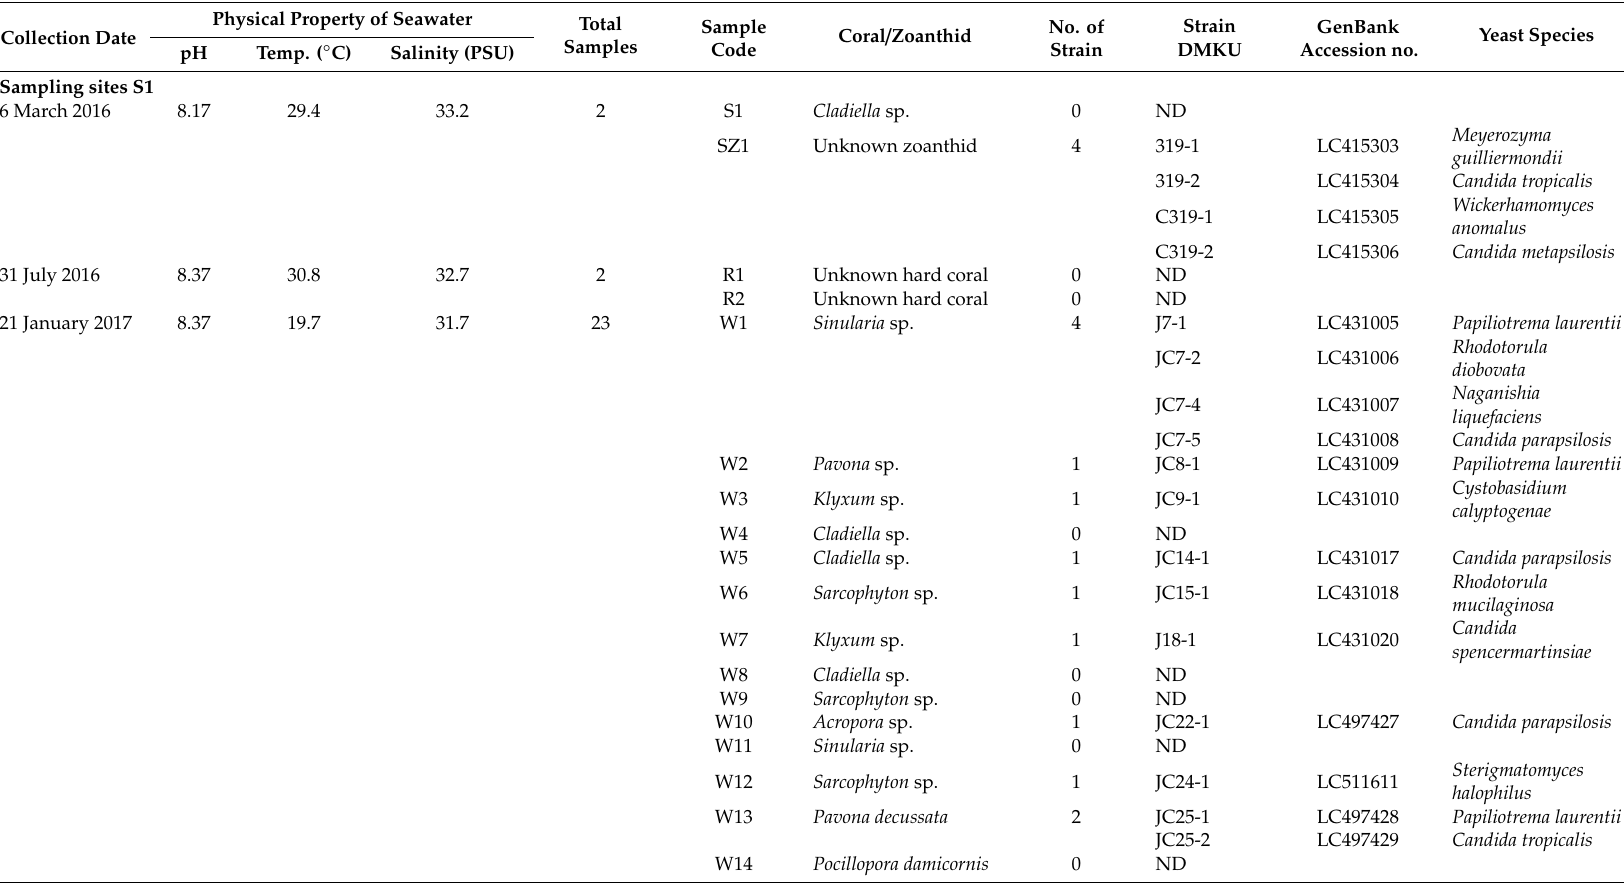
Table 1. Sampling location, physical properties of seawater in the sampling sites, and yeast isolated from corals and